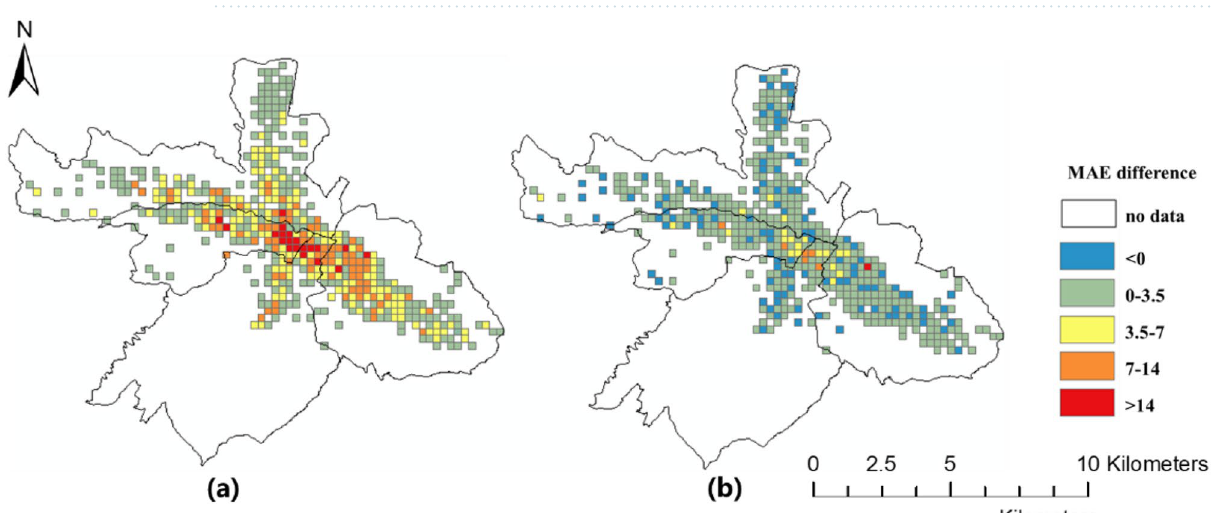
Figure 9. Spatial distributions of the MAE differences among different models: ( a ) FPM-geo and SVR; ( b ) FPM-geo and TGCN.